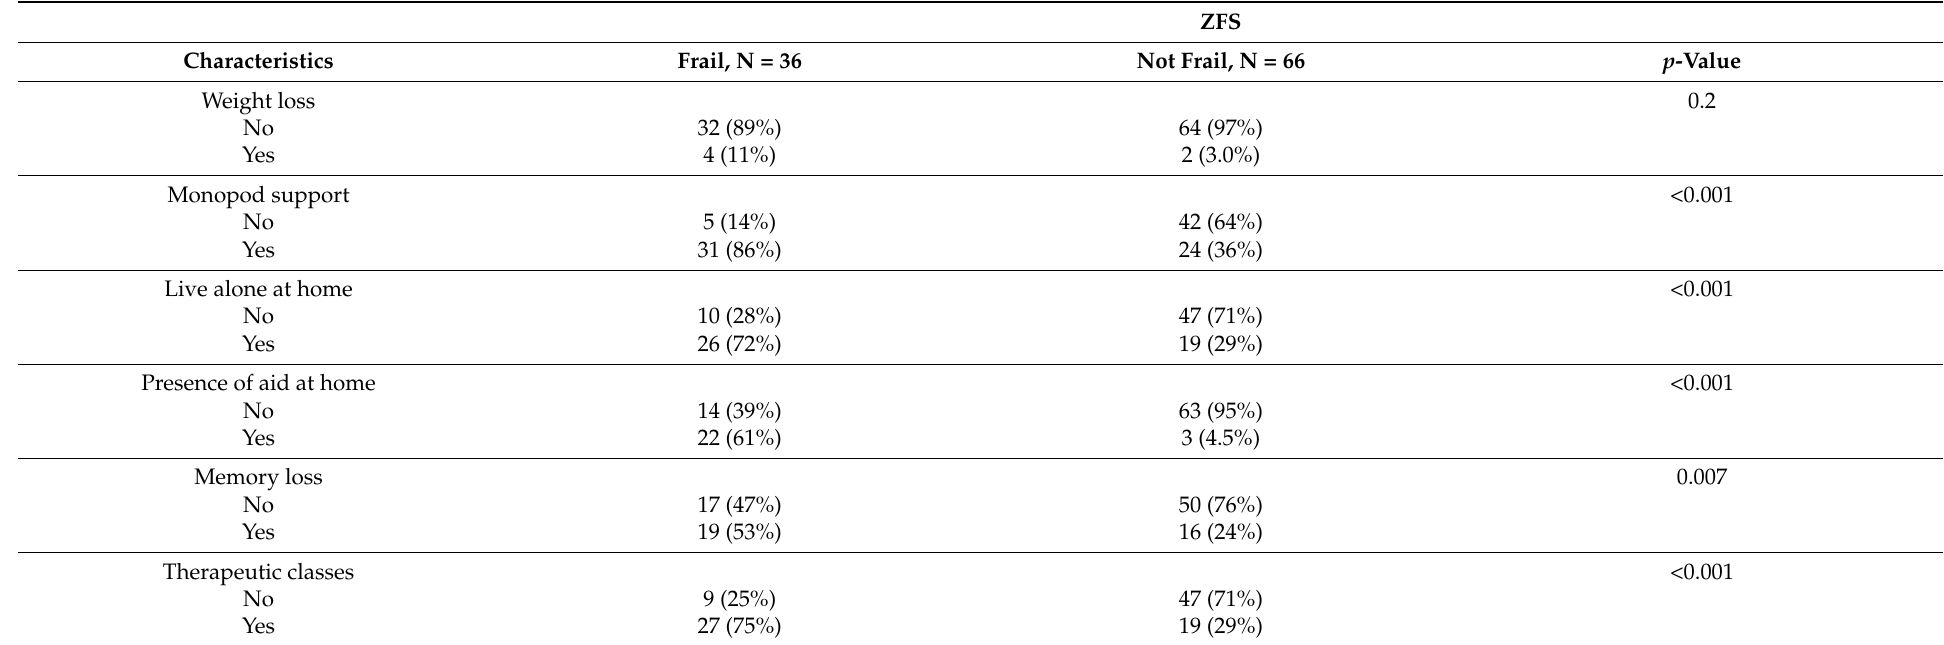
Table 7. Comparison of ZFS element scores between frail and non-frail